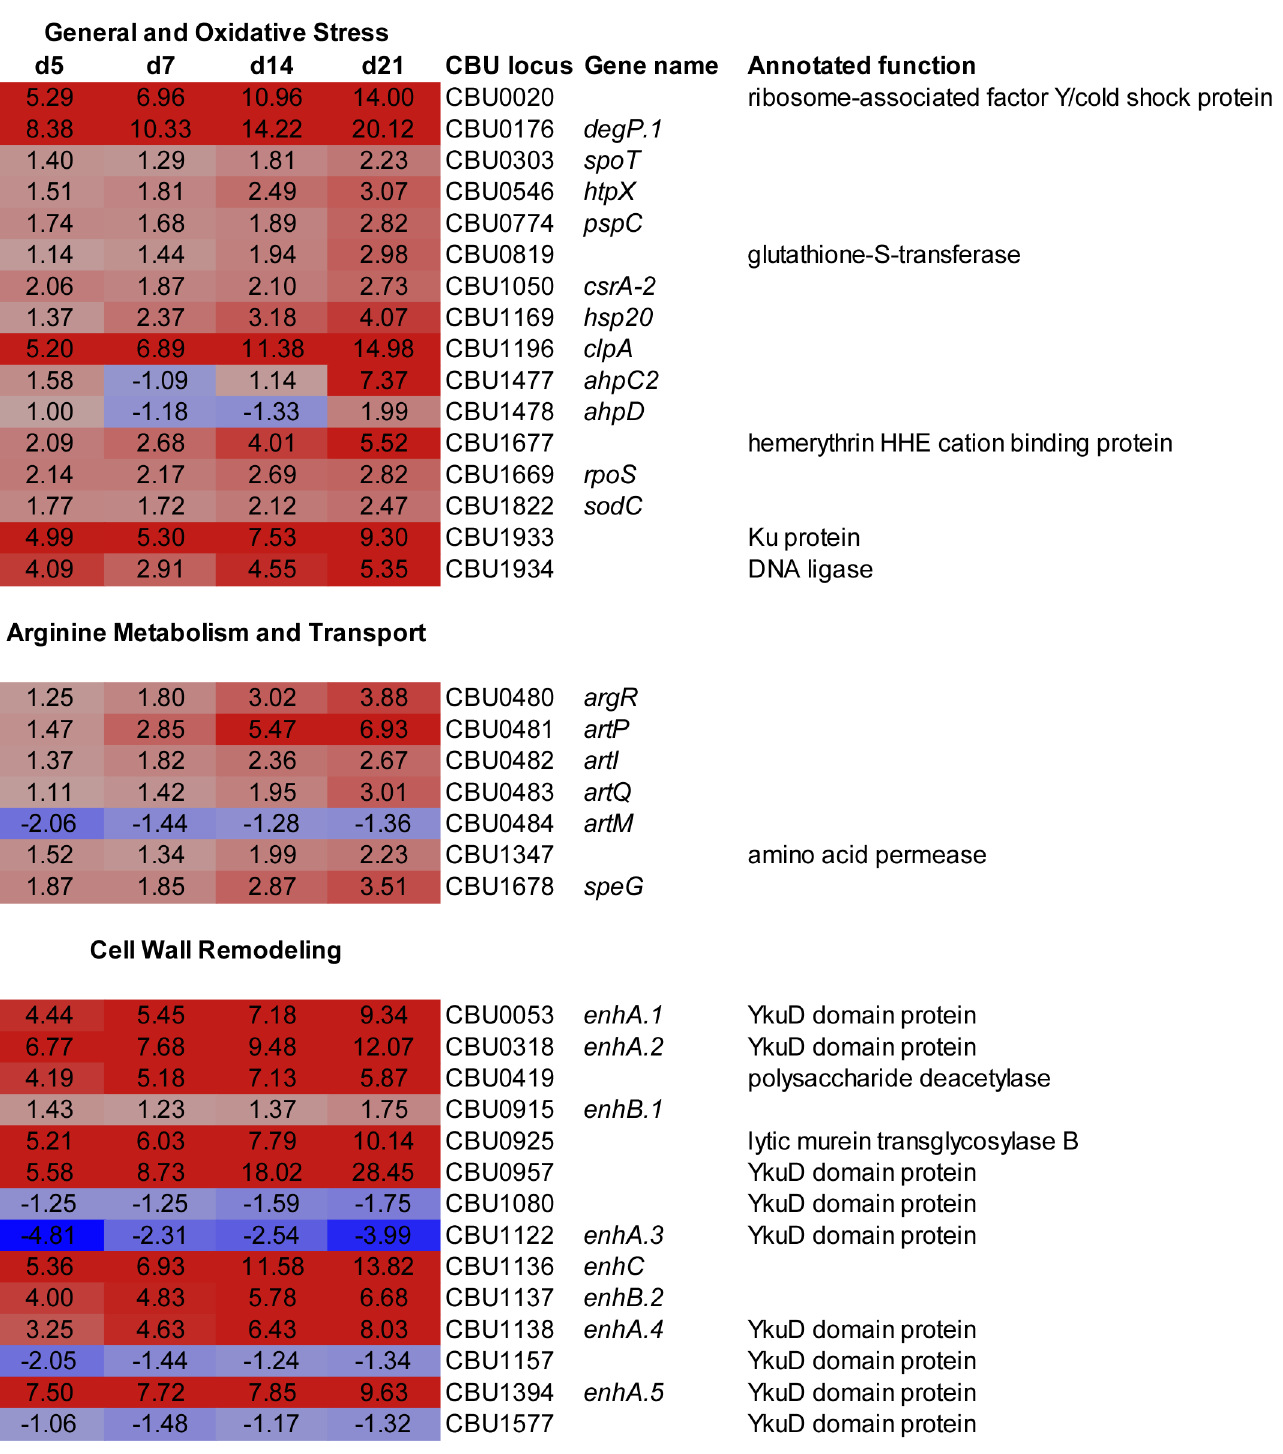
Fig 3. Expression levels of C . burnetii gene subsets that are upregulated during transition of LCV to SCV. Fold-increase in mRNA levels at 5, 7, 14, and 21 days post-infection relative to 3 days post-infection with a corresponding color code is depicted. Gene subsets shown are those involved in general and oxidative stress, arginine metabolism and transport, and cell wall